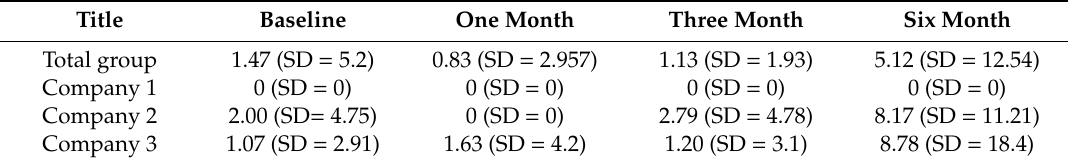
Table 9. Mean health related absenteeism in hours for the total group and individual company at baseline, one month, three month and six month follow-up.